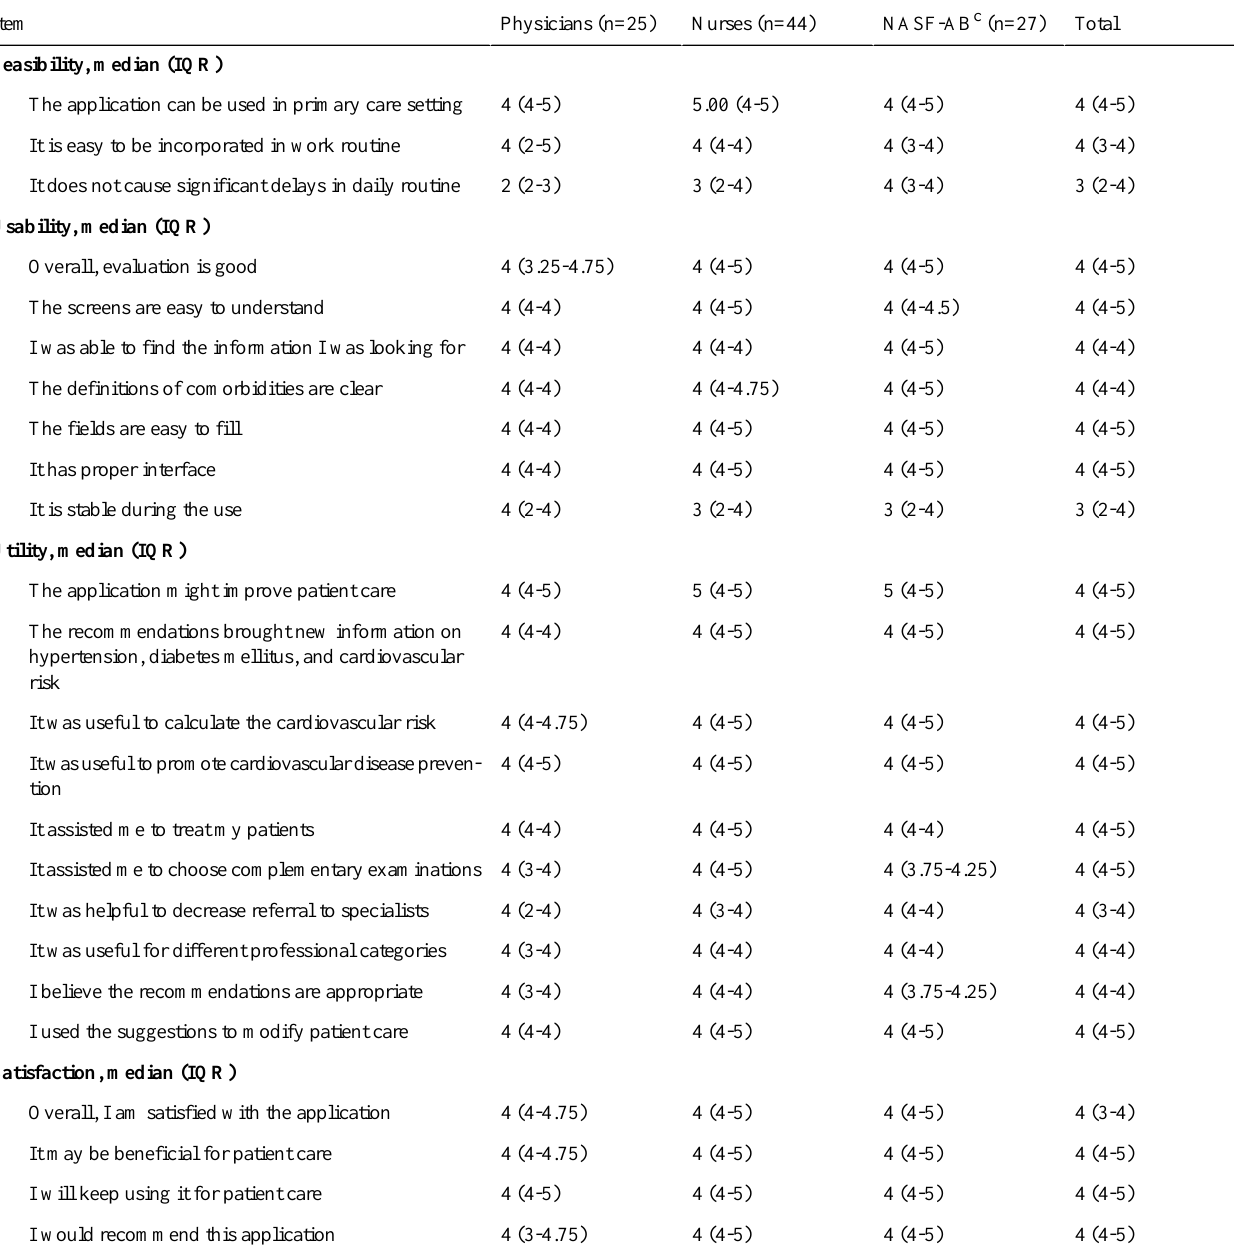
Table 2. Feasibility, usability, and satisfaction assessment scoresa